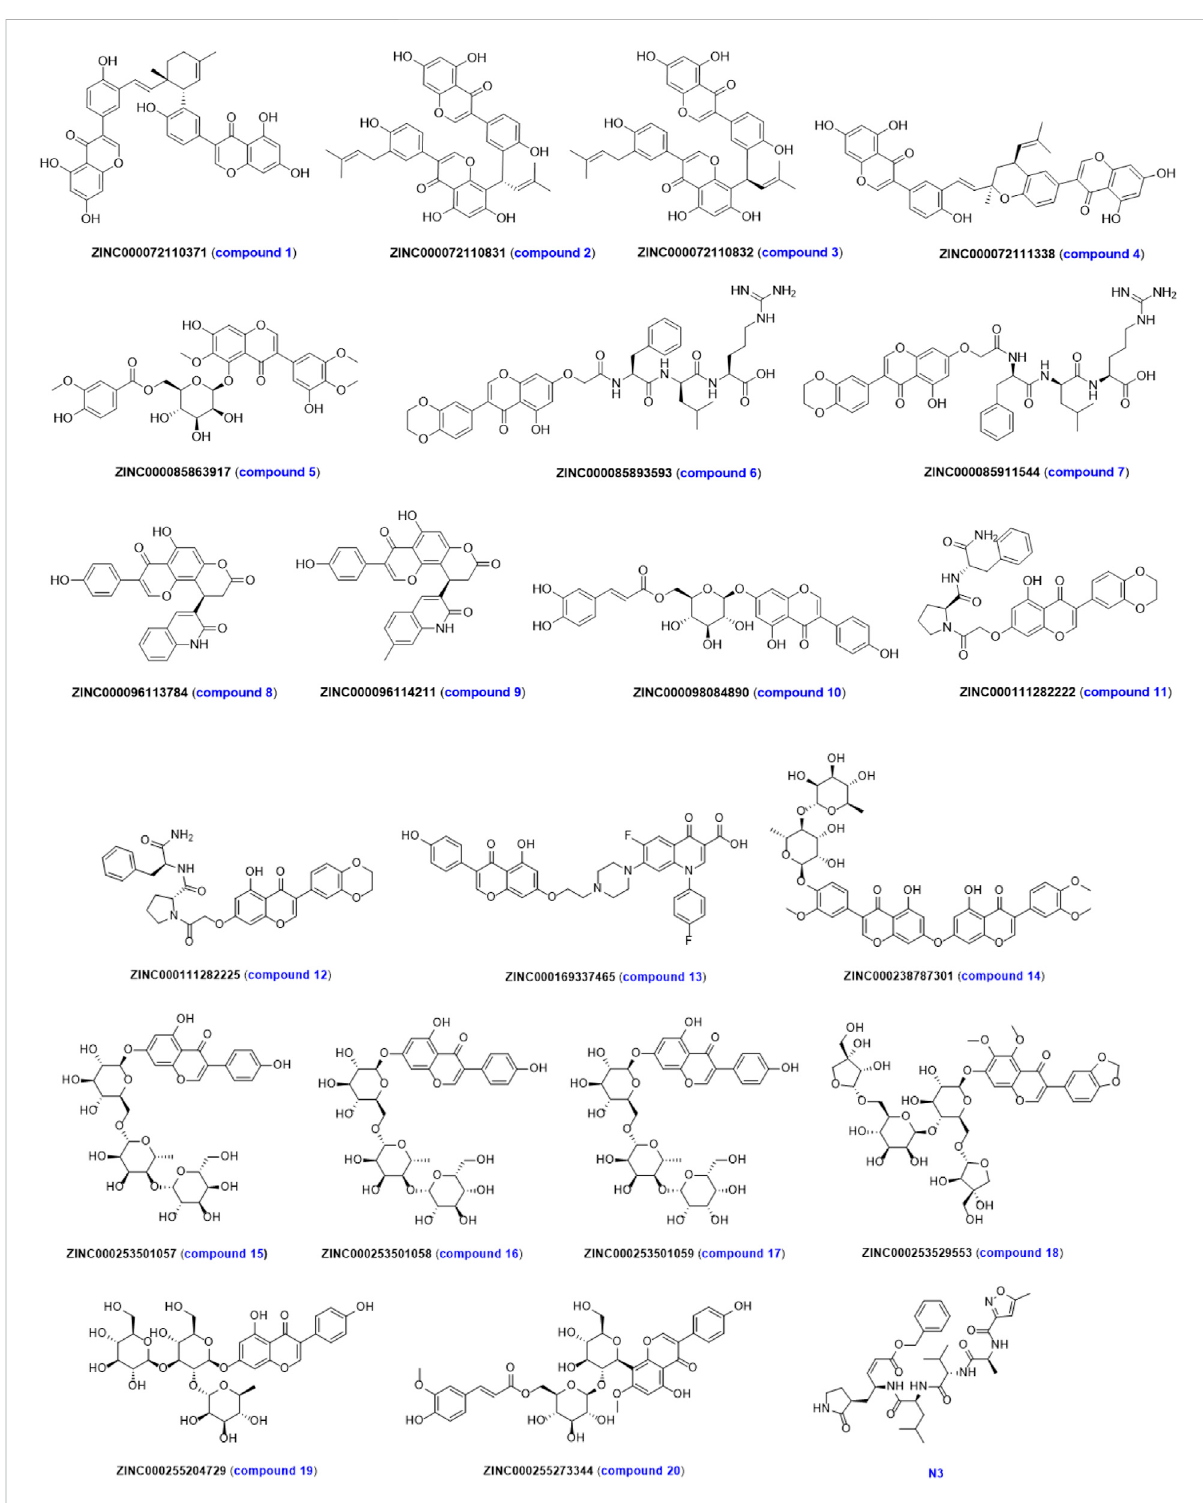
FIGURE 5 Structure of the top 20 compounds screened by normalized